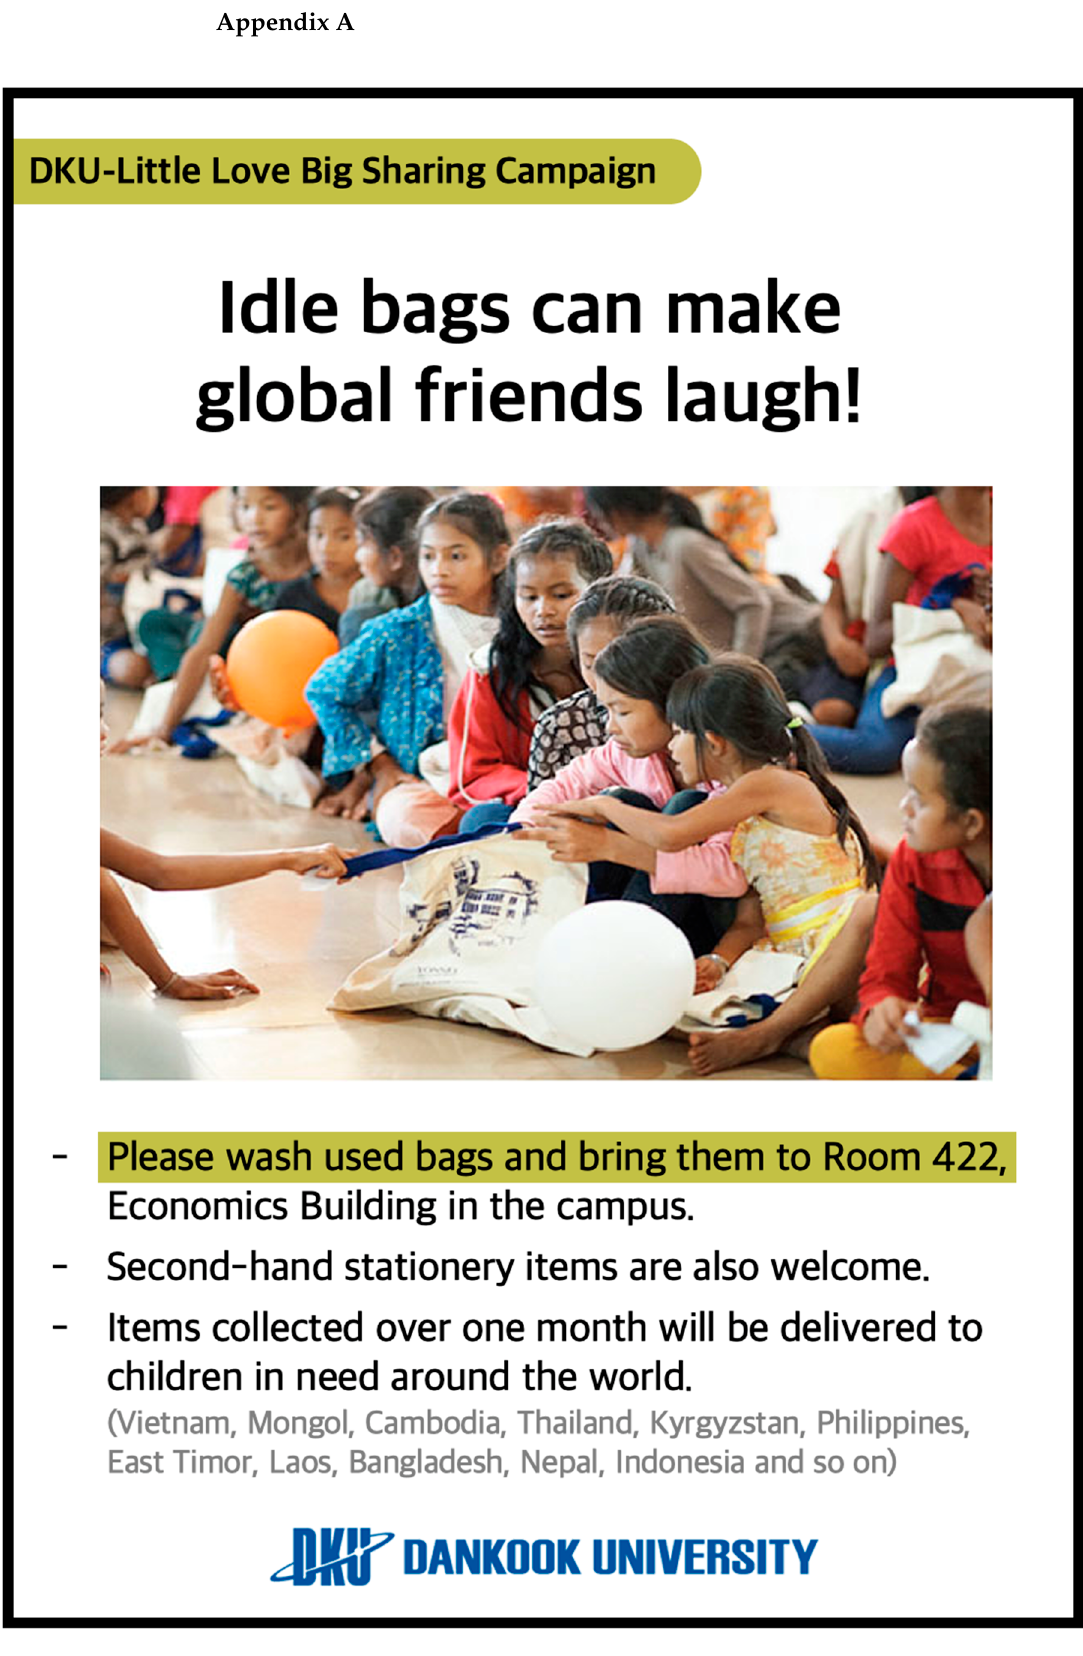
Figure A1. Intention to participate in a bag-donation campaign (Experiment 1).